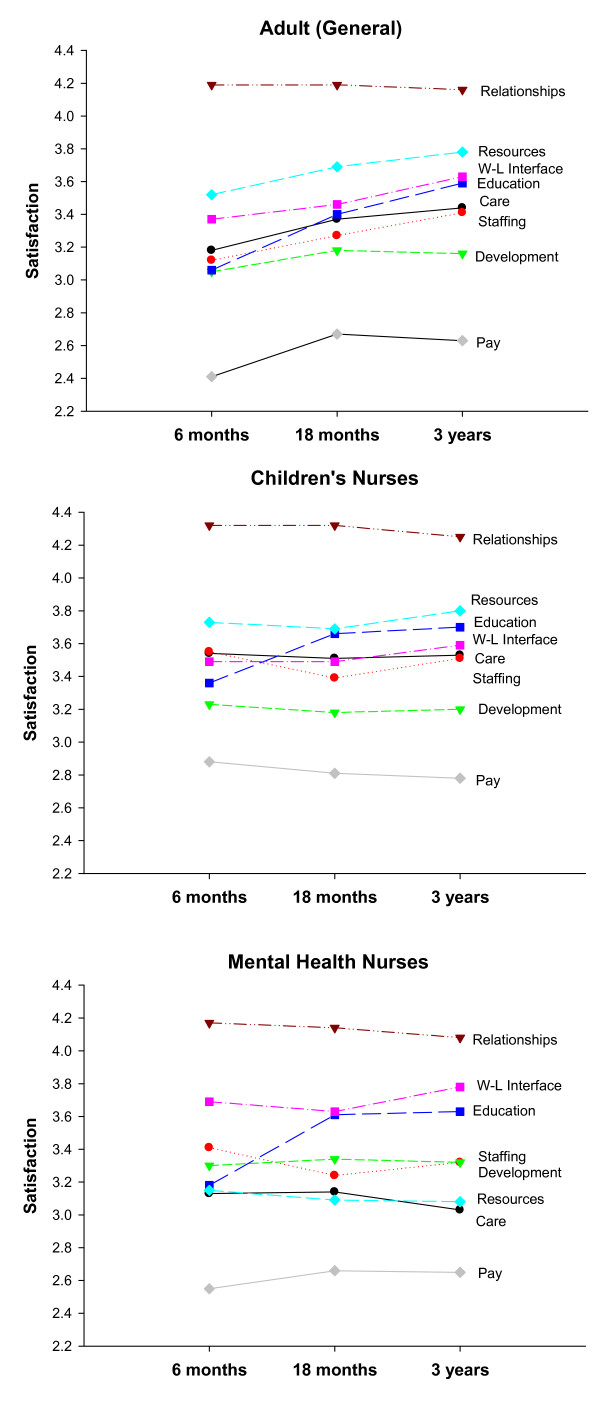
Satisfaction trends.